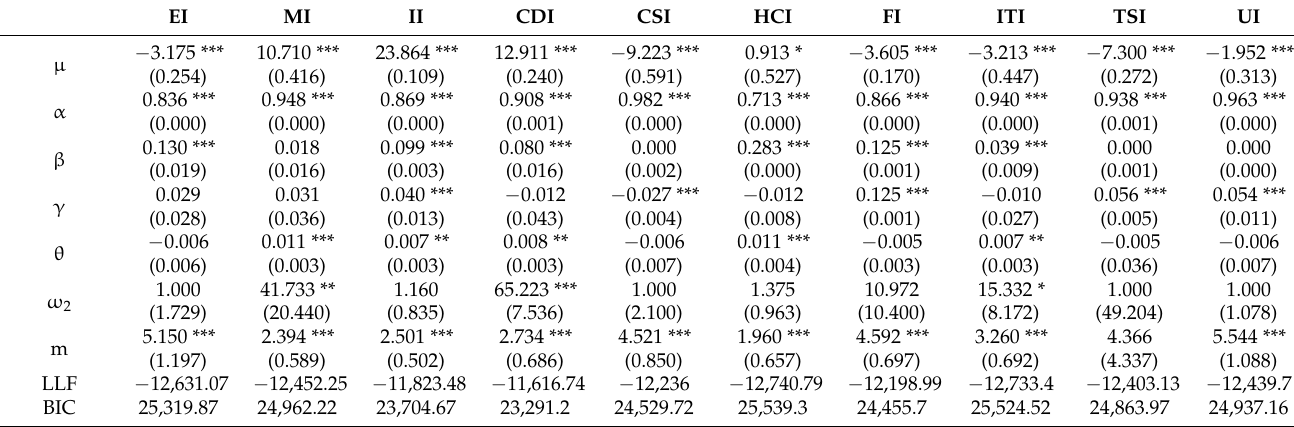
Table 8. GARCH-MIDAS regression results of GEPU index on volatility spillover levels of various industries in China 6 .